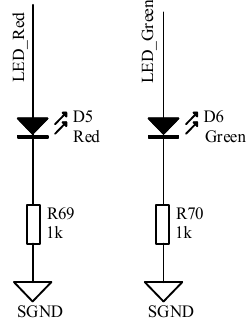
Figure 3. System operation indication circuit.